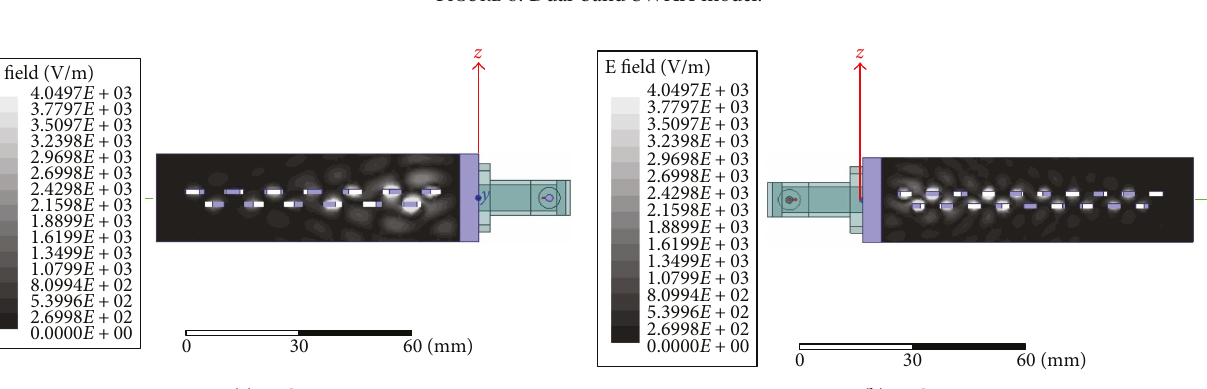
Figure 8: Dual-band SWAA model.